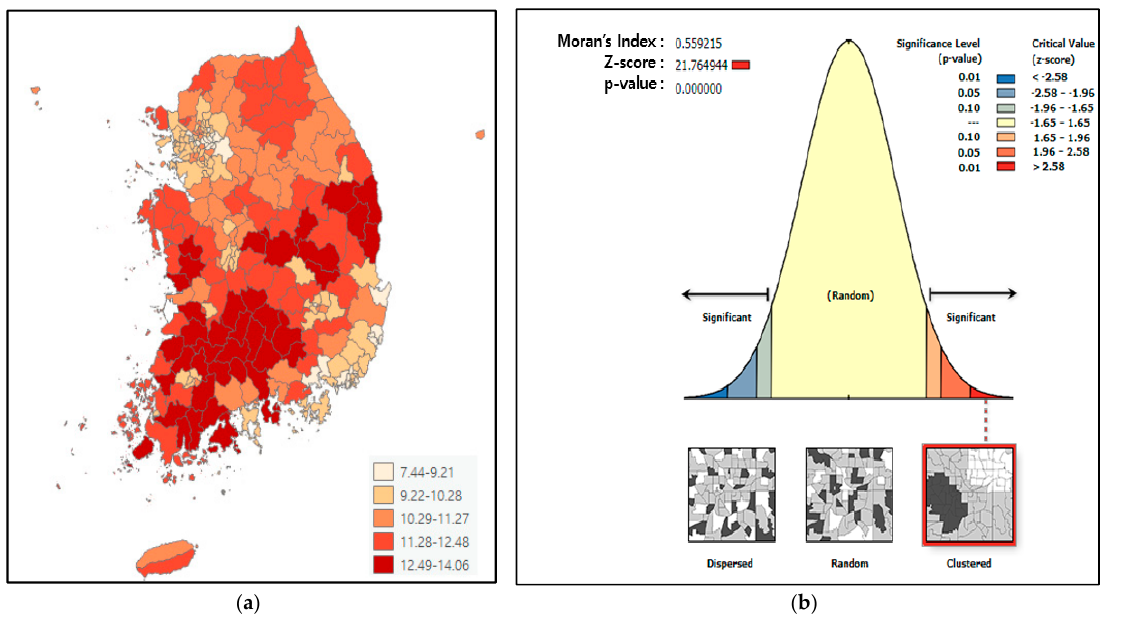
Figure 1. Spatial autocorrelation analysis of dementia prevalence. ( a ) Regional distribution of dementia prevalence; ( b ) global spatial autocorrelation analysis of dementia prevalence.